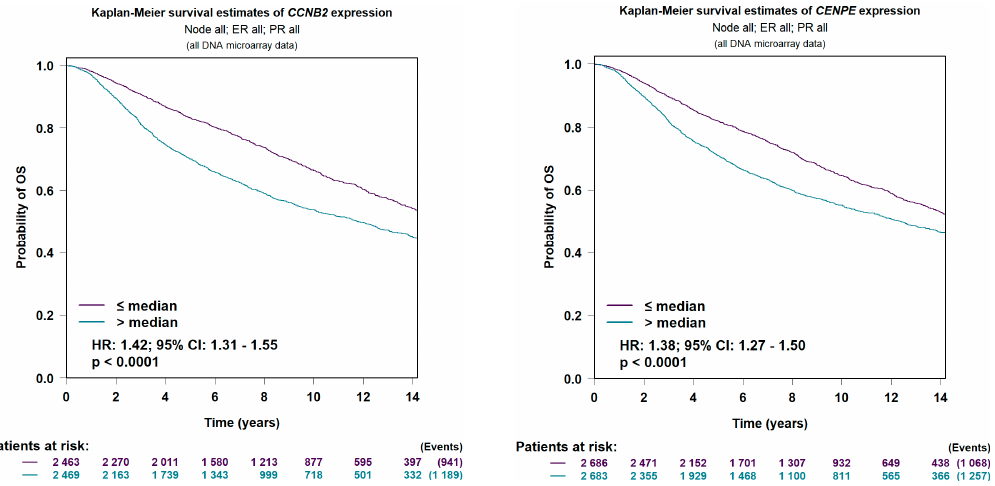
Figure 9. The prognostic value analysis of the eight hub genes in breast cancer using the bc-GenExMiner v4.6 web portal. Expression levels of the eight hub genes (CDK1, KIF11, CCNA2, TOP2A, ASPM, AURKB, CCNB2, and CENPE) are significantly associated with the OS of patients in breast cancer (all p < 0.05, HR > 1).